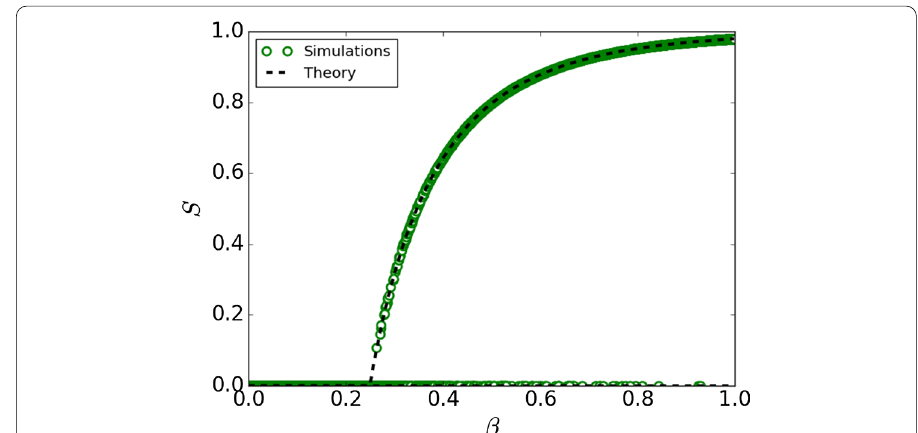
Fig. 7 Epidemic spread in ER networks. Theory is obtained from Eq. (12) and simulation performed with N = 10 6 and K = 4 . The epidemic threshold is β ER c = 1 / K = 1 /